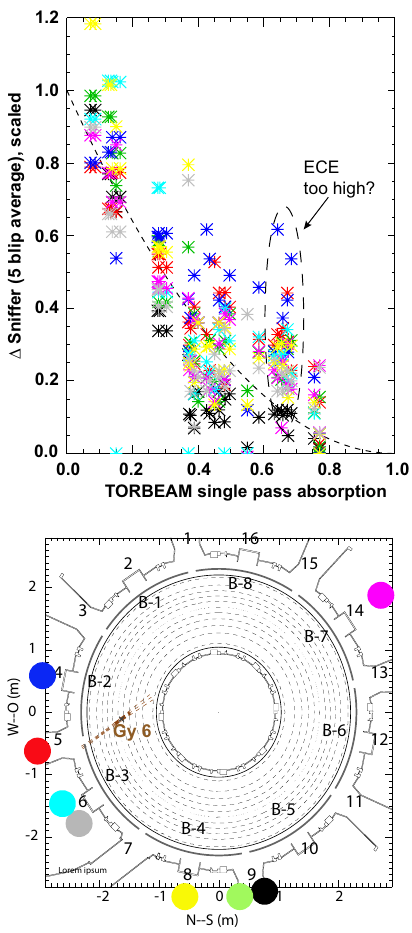
Figure 8. Top: Average increase of the sni ff er signals for the five subsequent blips during the sweeps of beam 6 plotted against the single pass absorption calculated with TORBEAM. Some data appear twice: in case IDA T e was significantly di ff erent with ECE and TS, two TORBEAM runs were made using the di ff erent T e profiles. Most points in the vertically elongated dashed ellipse correspond to non-thermal electron distributions using ECE. The corresponding ones using TS lie at lower single.pas absorption (lower T e , fig. 6). The sni ff er increase was scaled with reference to the empty vessel reference. a The data is underlined with a parabola, see text. Bottom: Toroidal location of sni ff er-probes and beam 6. Absolute values of more distant probes are lower, but this is hidden by the normalization as explained above. a Additional scaling factors between 0.5 and 2.5 had to be introduced for the di ff erent probes, minimizing the scatter at the lowest and largest absorption and aiming at a value of unity for zero TORBEAM absorption. These factors were adjusted by eye. An explanation may be the lack of mode mixing by plasma fluctuations in the empty vessel, giving rise to less variable highly localized interference structures, no longer smeared out by time averages over the mode sensitive sni ff ers